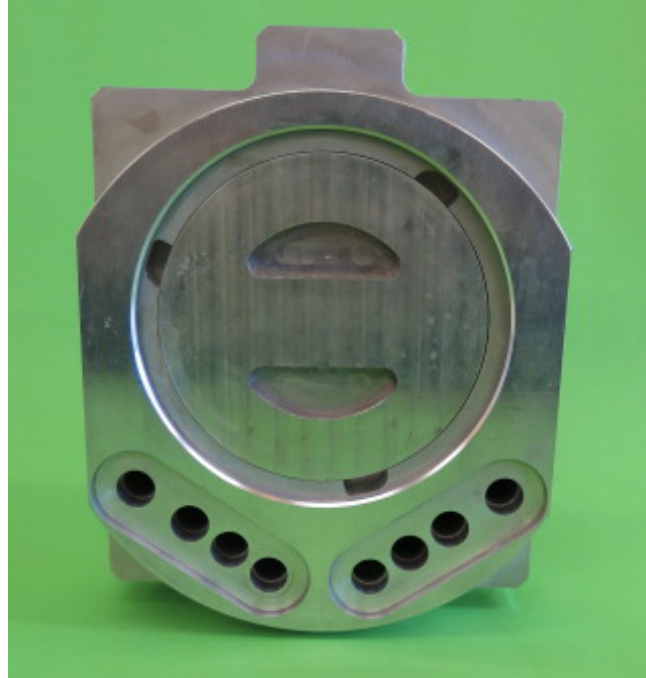
Figure 8. A closed tandem target holder with the bayonet-mount plug in